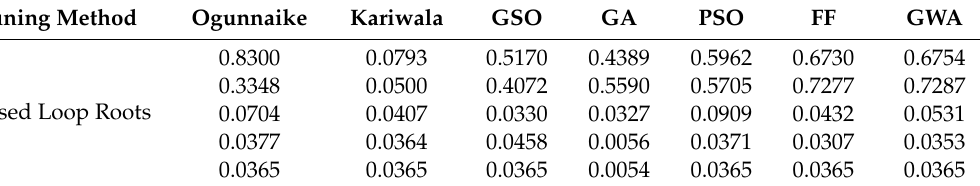
Table 9. Example 1: Roots with di ff erent tuning methods.